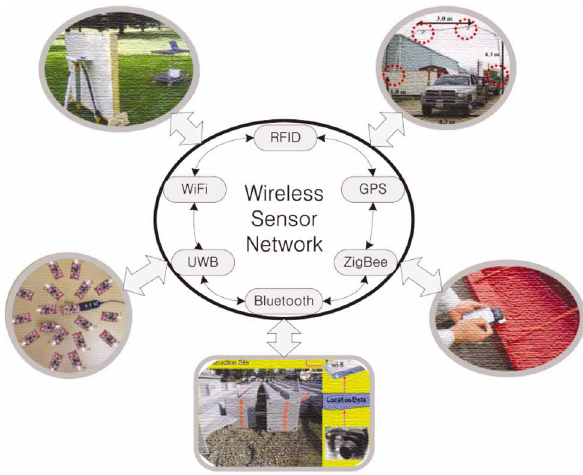
Fig. 1. Various wireless technologies with different functionali- ty, capability and scope of application in construction industry (Song et al. 2006; Chin 2006; Pardasani et al.